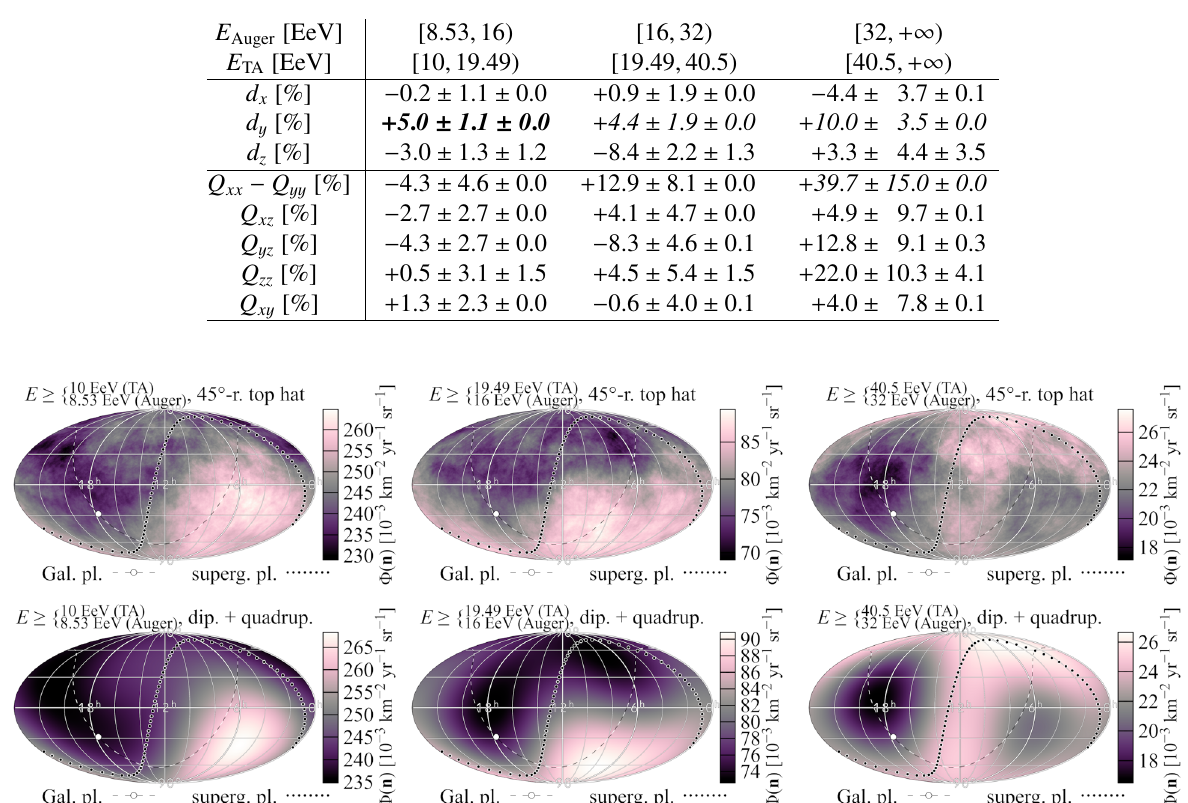
Table 1. Our measurements of the dipole and quadrupole moments. The first uncertainty is statistical, the second is due to the uncertainty in the cross-calibration of energy scales. Values in italics ( bold ) are locally significant at ≥ 2 σ ( ≥ 4 σ ).